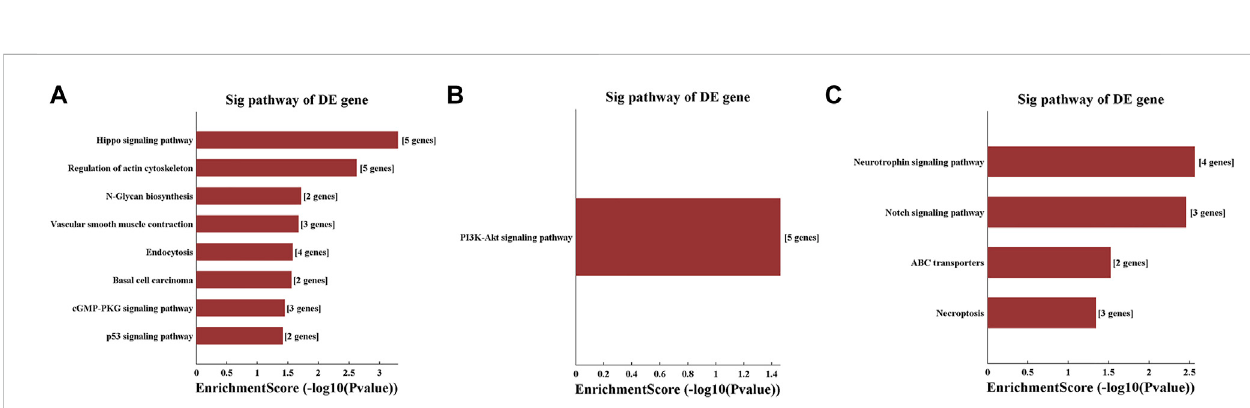
pathways by targeting BDNF(Qin et al., 2019). Schimmel (Schimmel, 2018) showed that the cleavage of tRNAs at the anticodon by the nuclease angiogenin generates 5 ′ and 3 ′ tsRNAs and that the 5 ′ tsRNAs could inhibit global protein synthesis under stress. Blanco et al.